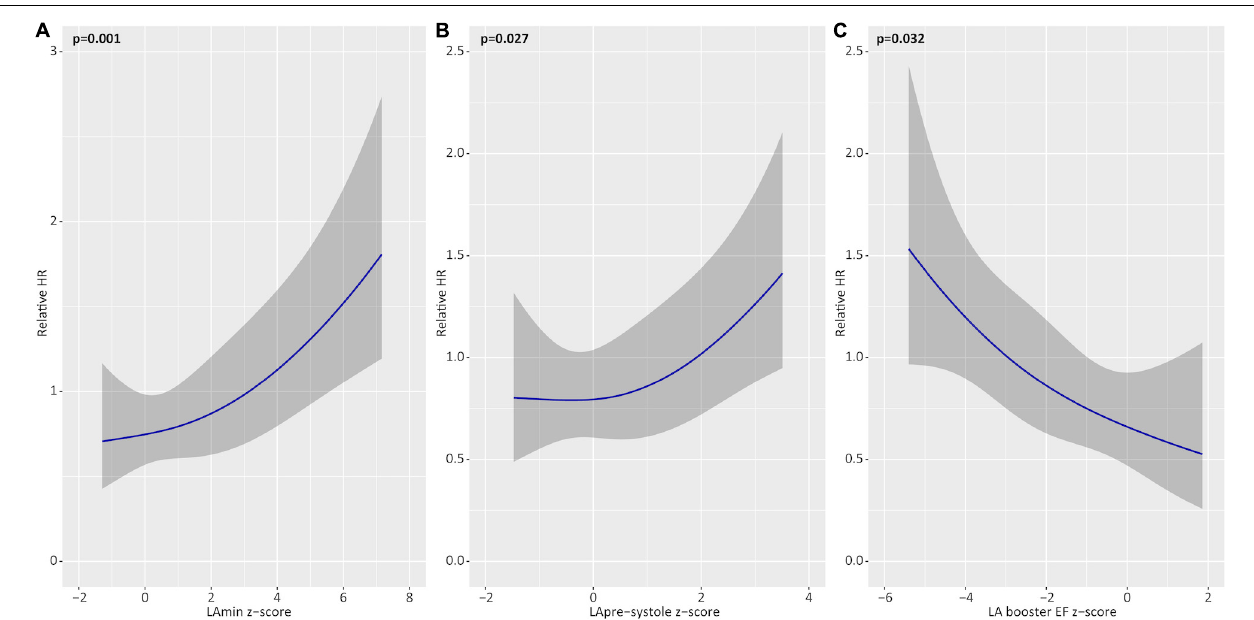
FIGURE 4 | Multivariable associations of left atrial (LA) parameters with the primary outcome. Adjusted hazards of atrial fibrillation recurrence for Z-score based deviations (relative to healthy reference values) for minimum LA volume (LAmin; A ), pre-systole LA volume (LApre-systole; B ), and LA booster ejection fraction (EF; C ). Shown as partial effect plots for multivariable associations with relative hazard ratios plotted across the range of restricted cubic spline-transformed variables. All models are adjusted for age, hypertension, diabetes, alcohol consumption, and pre-procedural anti-arrhythmic medication